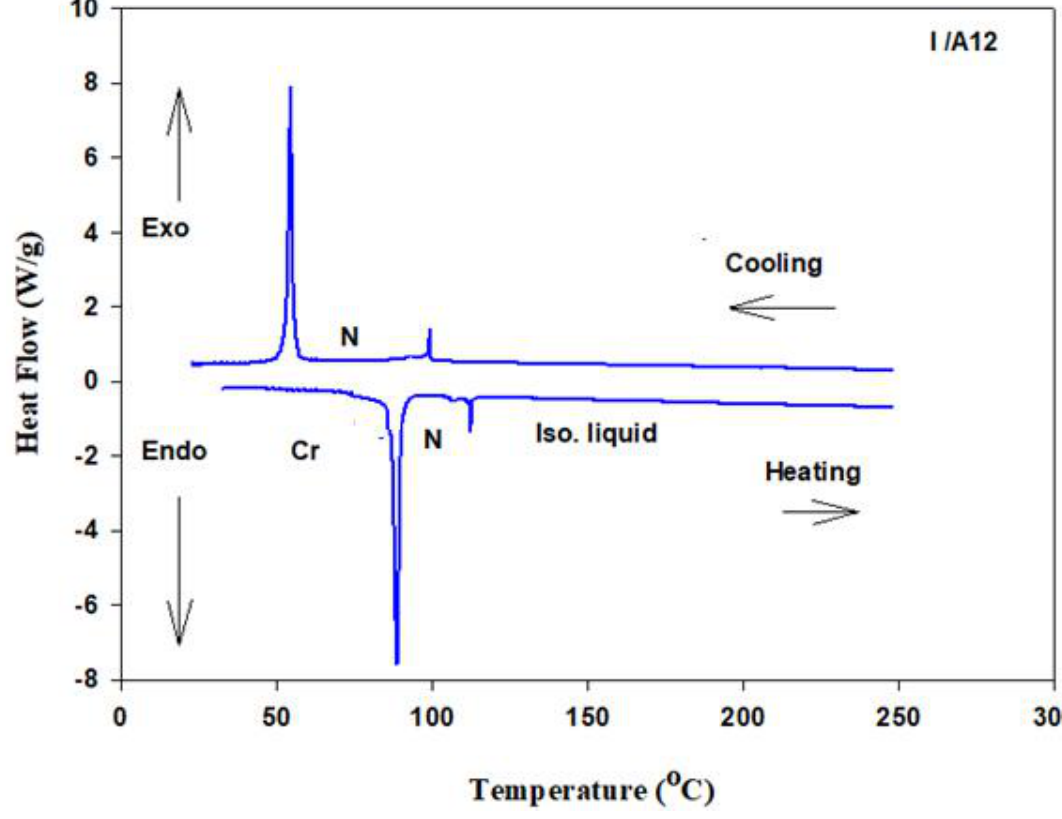
Figure 4. Differential scanning calorimetry (DSC) thermograms for I/A12 upon second heating/cooling cycles.